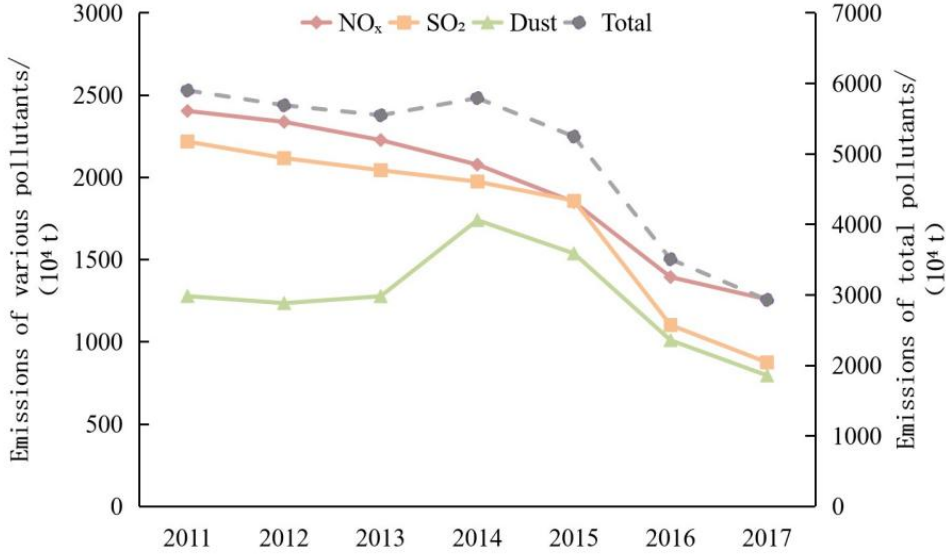
Figure 2. Changes in annual average emissions of three air pollutants (NO x , SO 2 , and dust) in China (2011 – 2017).